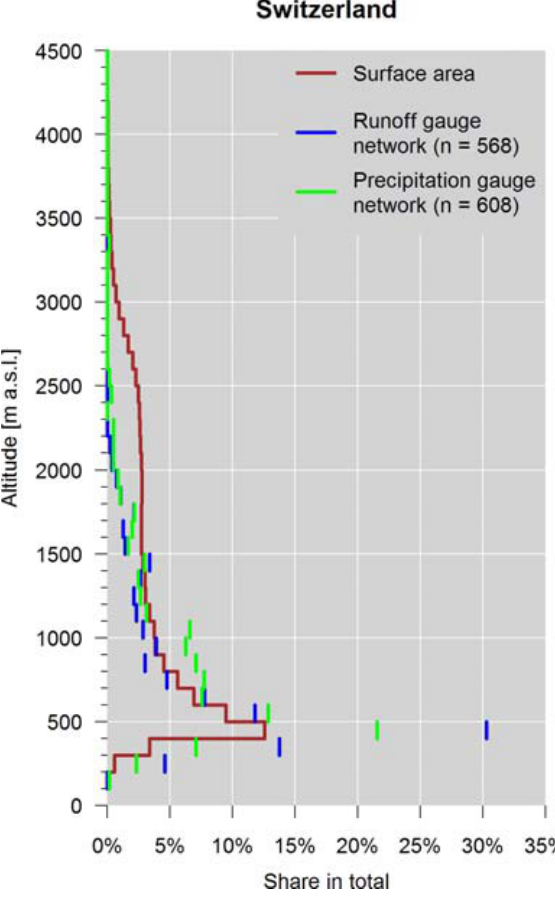
Fig. 5. Altitudinal distribution of the runoff and precipitation gauge networks in Switzerland compared to